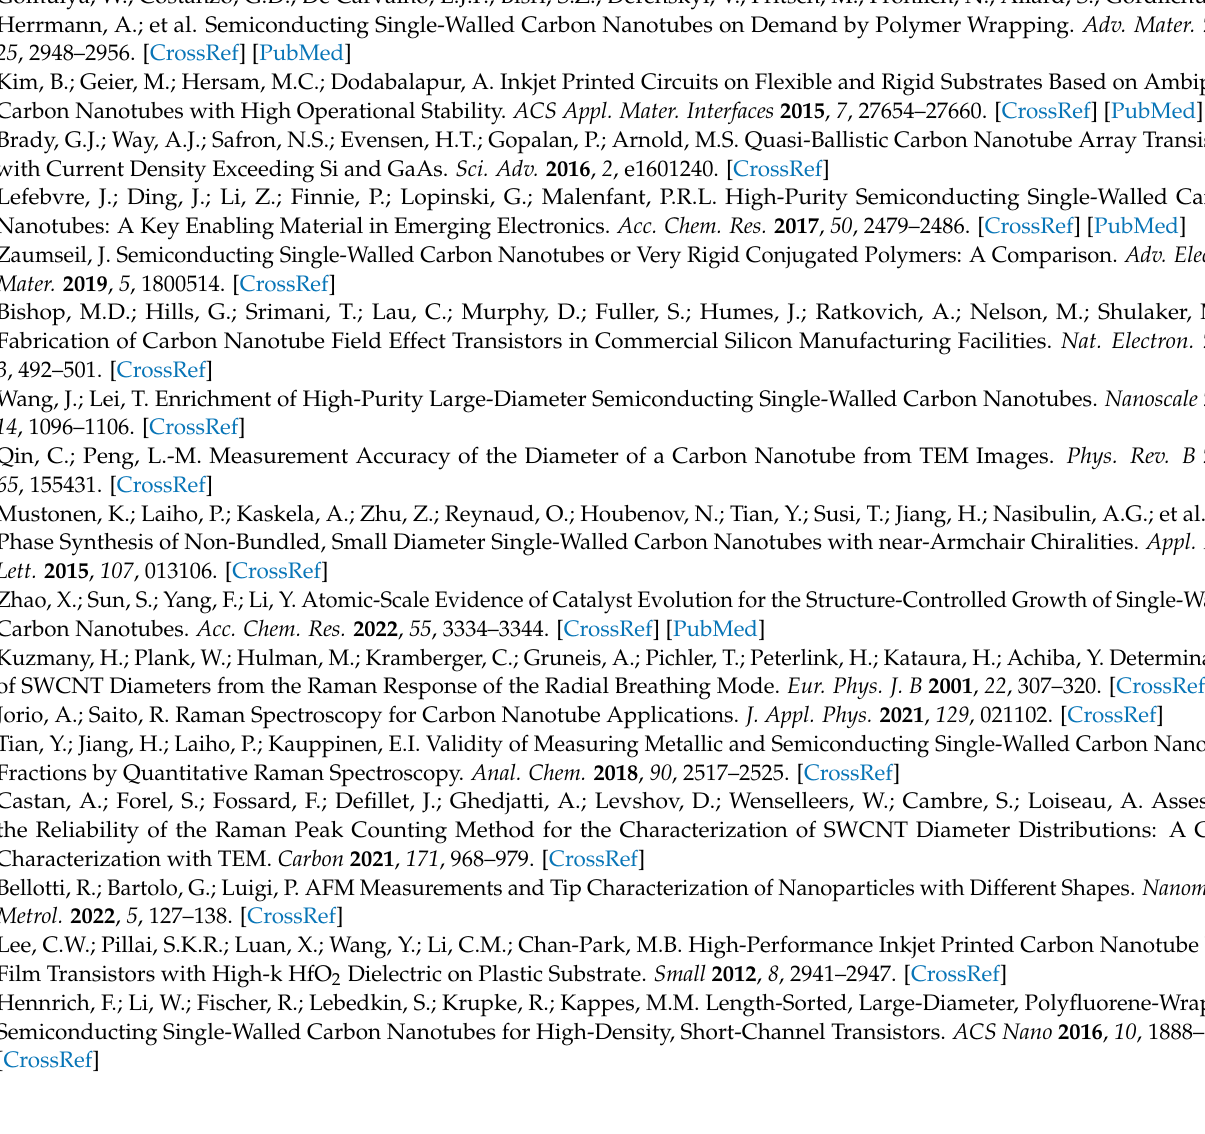
F vs height, Figure S2: Representative images of networks made of different nanotubes, Figure S3: Evaluating the repeatability of the analysis method. Figure S4: Raman spectra of the radial breathing mode of a PFDD/SWCNT